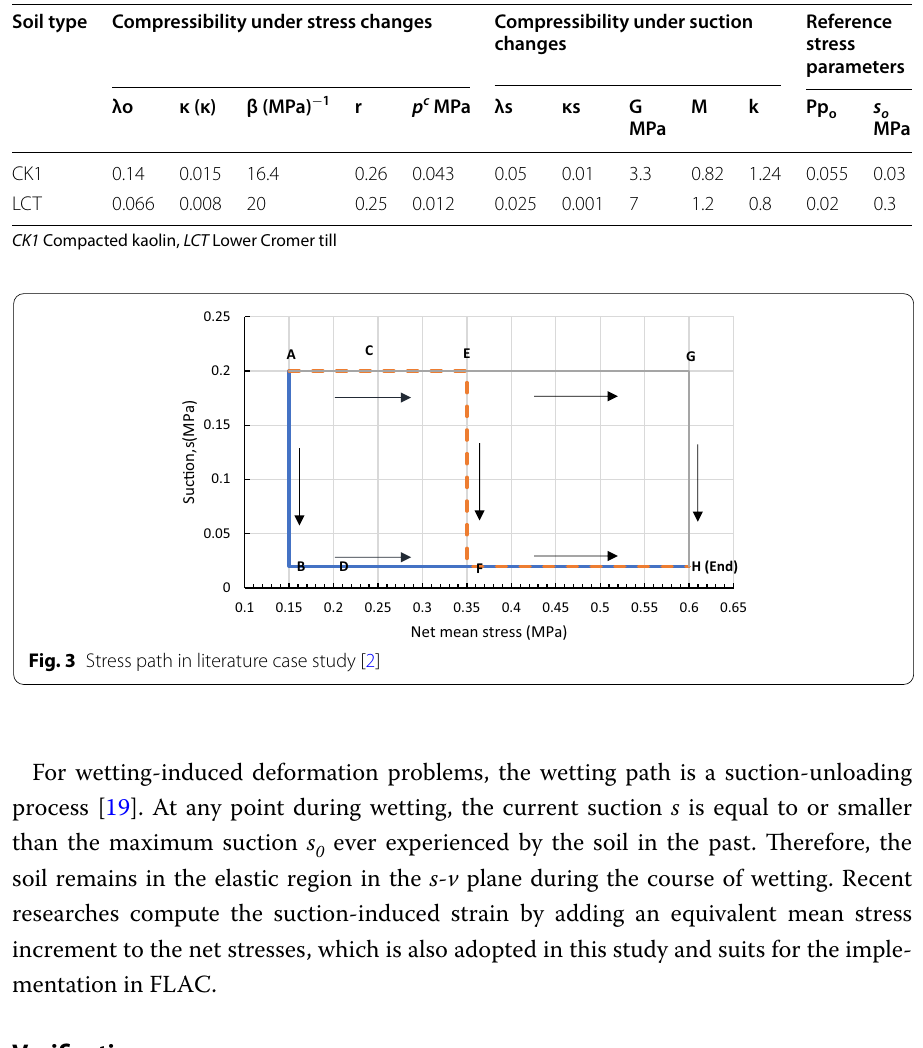
Table 1 BBM parameters as adapted from Alonso et al. [2] Soil type Compressibility under stress changes